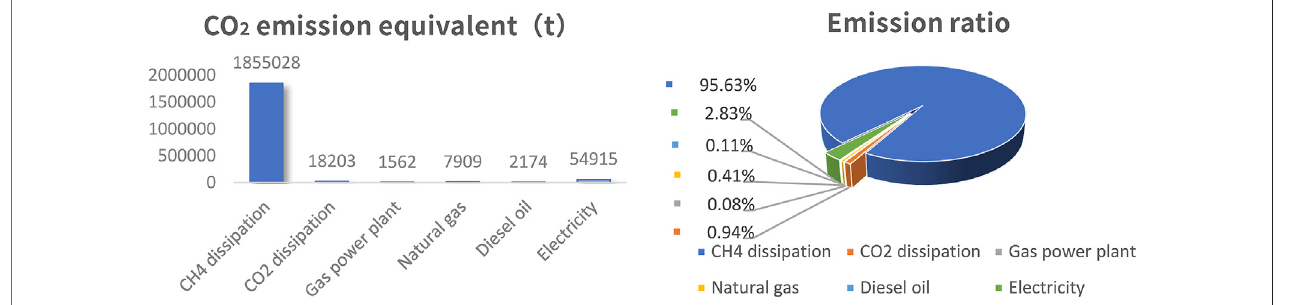
FIGURE 5 | Carbon emission by source and emission proportion of Wangpo coal mine.